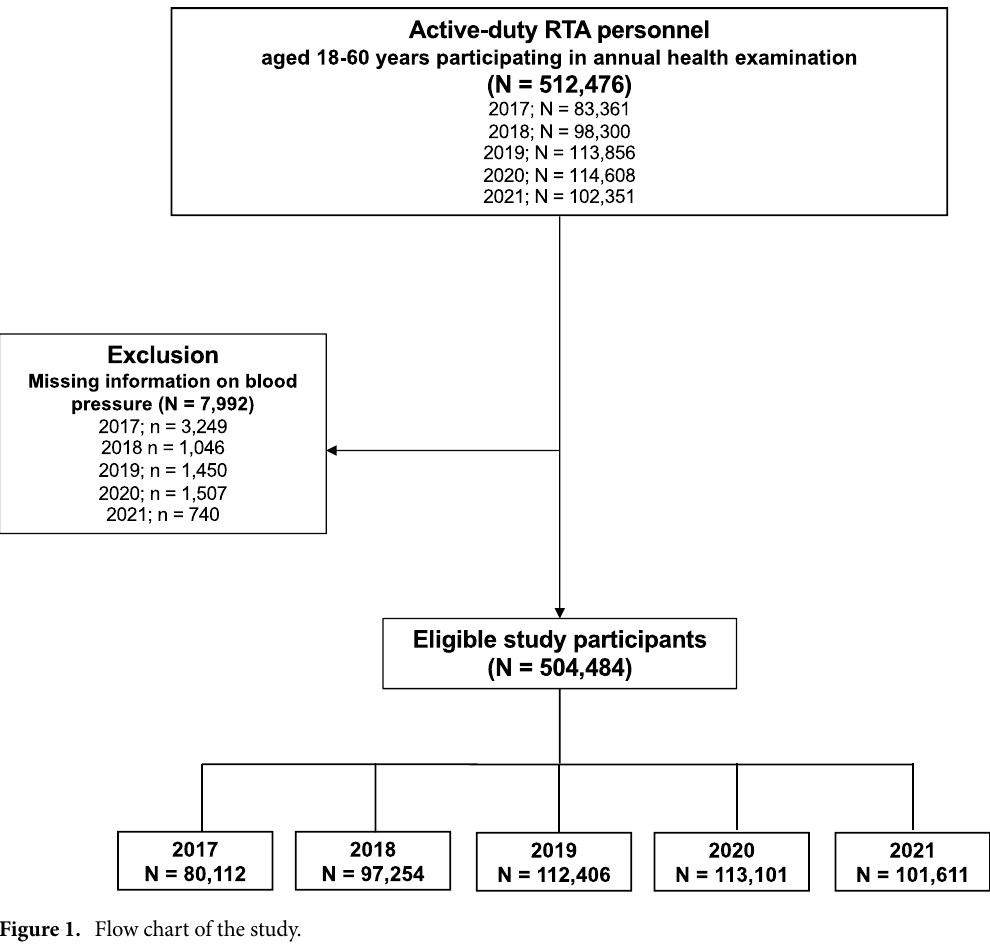
Figure 1. Flow chart of the